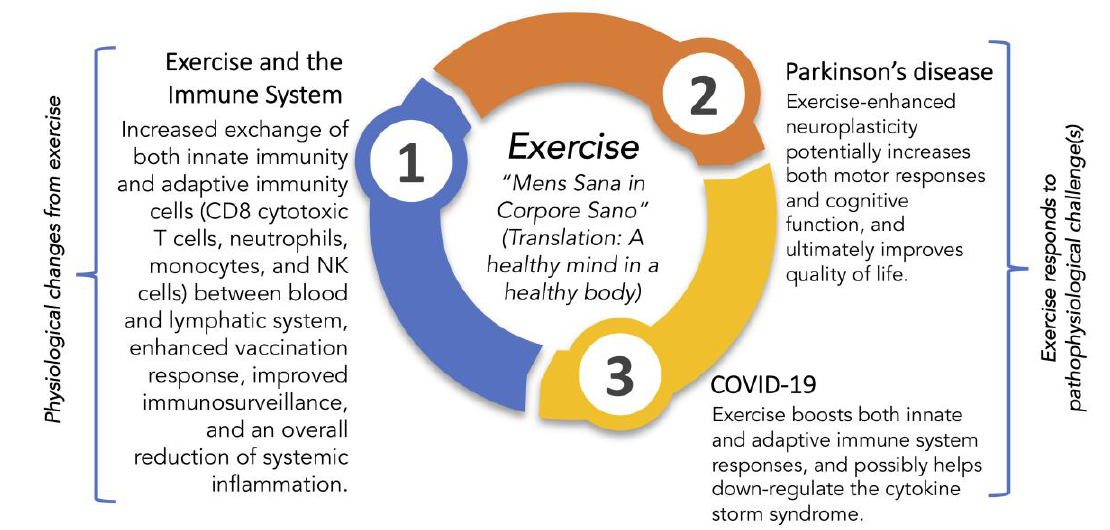
Figure 1. An overview of some health benefits of exercise by modulation of the immune system and putative protective roles for exercise in encounters with Parkinson’s disease and SARS-CoV-2. Juvenal’s centuries-old dictum to seek a healthy mind in a healthy body is from [42] .